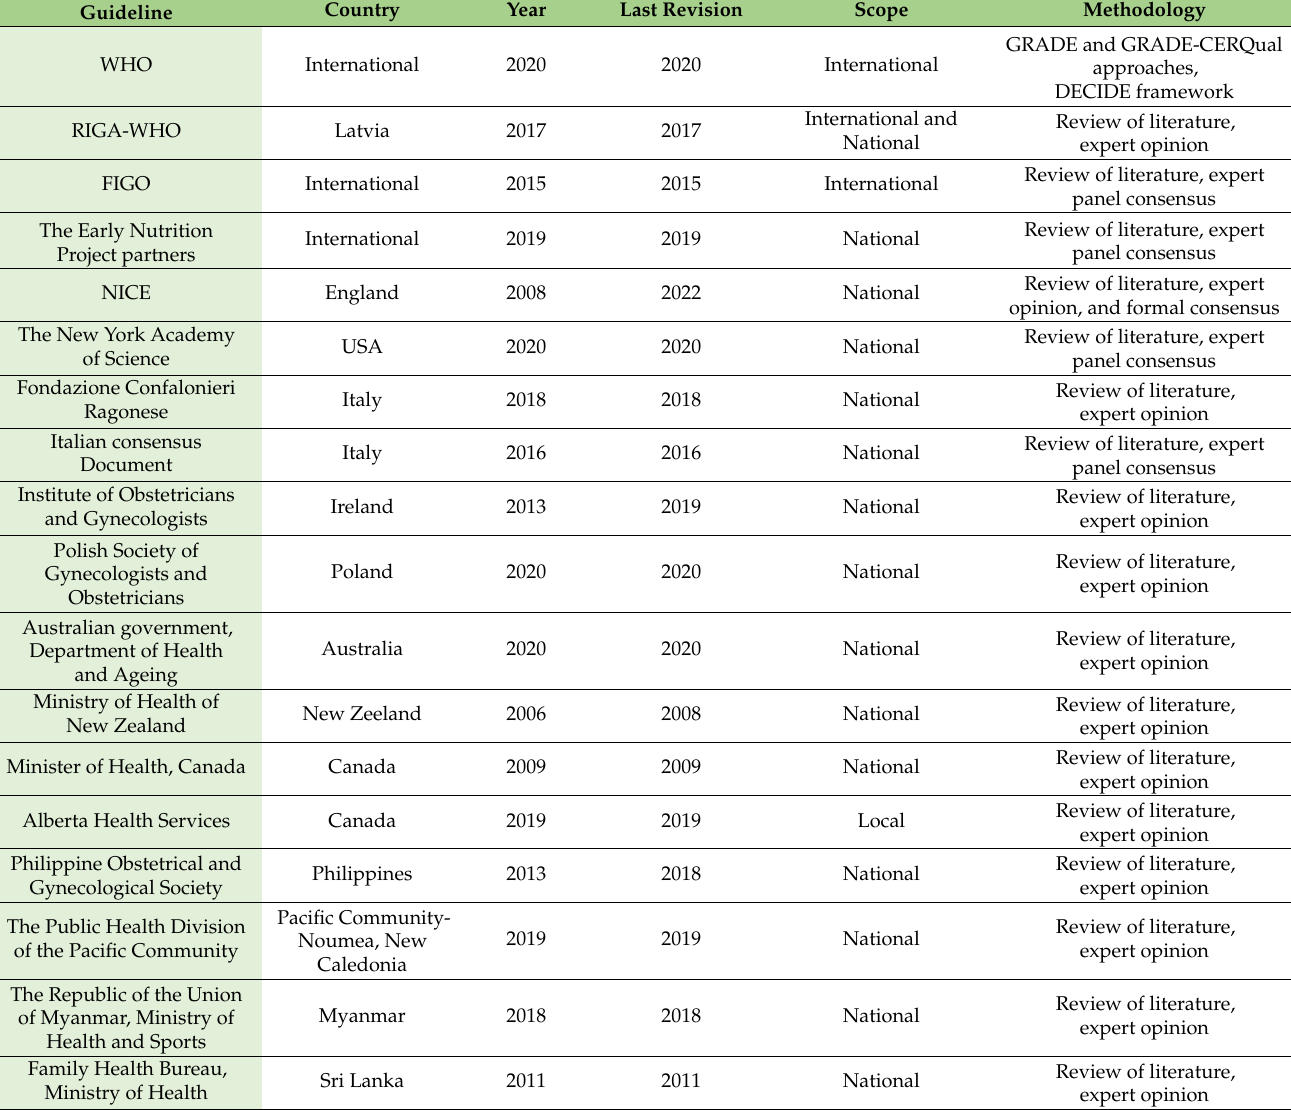
Table 2. General characteristics of CPGs